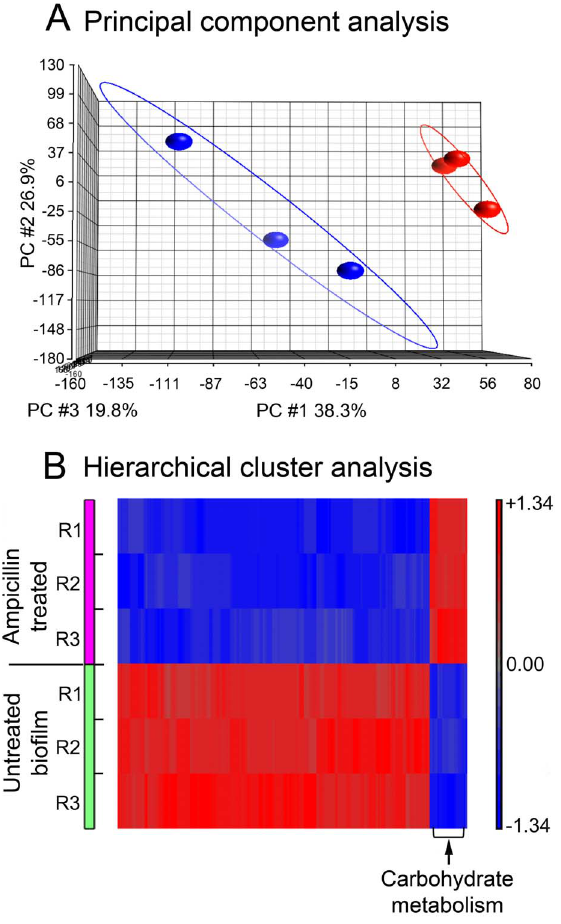
Figure 8. mRNA analysis of PittGG biofilms. A. Principal component analysis of microarray gene expression of the PittGG biofilm bacteria (NTHi) exposed to 170 ng/mL ampicillin. The major variations (PC1, PC2, and PC3) are visualized in 3-dimensions. The three PCs together accounted for about 85% of the variations present in the entire data set. A distinguishable grouping difference can be seen between ampicillin treated (in blue) and non-treated (in red) samples. B. Hierarchical cluster of significantly differentially expressed genes in the PittGG biofilm bacteria (NTHi) treated with 170 ng/mL ampicillin. Heatmap visualization of 59 significantly regulated genes by ampicillin treatment. Results from the 3 replicate experiments (R1, R2 and R3) of ampicillin-treated and untreated biofilms are presented. A hierarchical clustering was analysed on the probe sets representing the 59 genes including 8 up and 51 down regulated gene transcripts with filter criteria of at least 1.5 folds change plus P # 0.05 and FDR less than 0.05. Rows: samples; columns: genes. The up-regulated genes relating to carbohydrate metabolism are indicated.